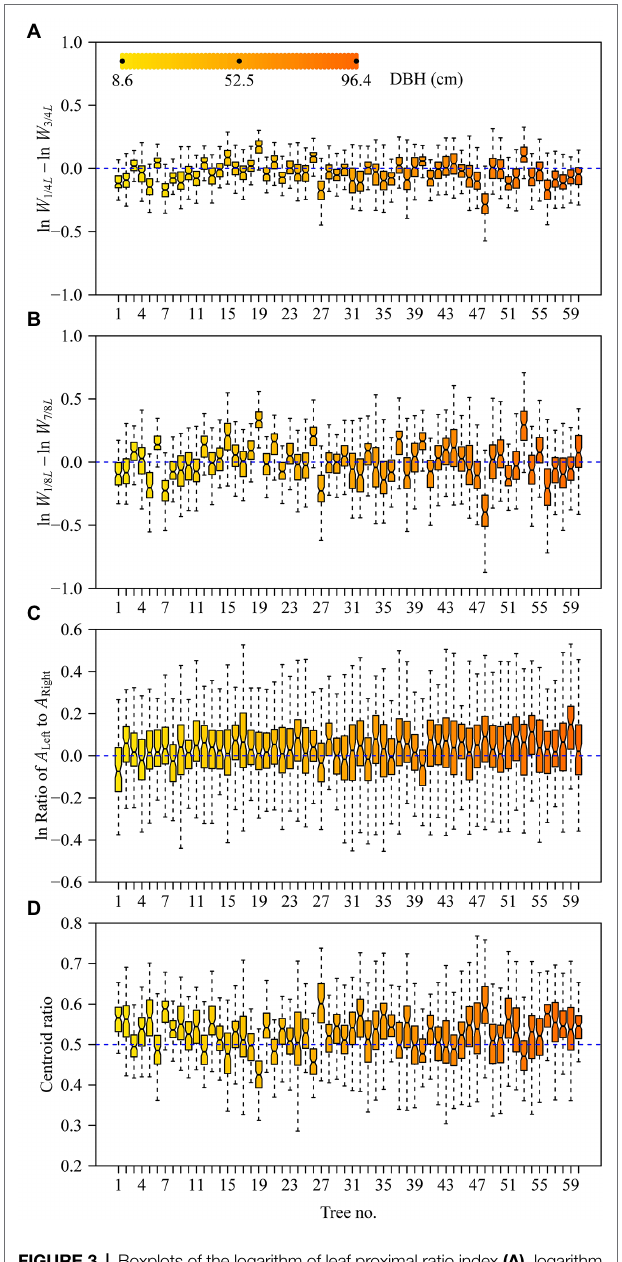
FIGURE 3 | Boxplots of the logarithm of leaf proximal ratio index (A) , logarithm of leaf distal ratio index (B) , logarithm of the area ratio of the left side to the right side (C) , and centroid ratio (D) . The notches of boxes represent the medians, and the colors of boxes reflect their DBH values (see panel A